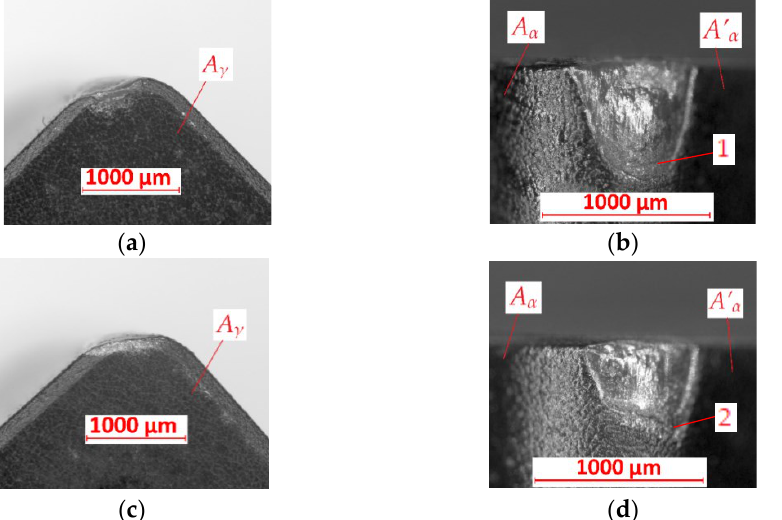
Figure 7. Results of tool ’ s wear measurements of cutting inserts after turning with f = 0.1 mm/rev of ( a , b ) FEPA 046 samples; ( c , d ) FEPA 100 samples: A γ — rake surface, A α — principal flank surface, A ’ α — auxiliary flank surface, 1 , 2 — places of abrasive wear.